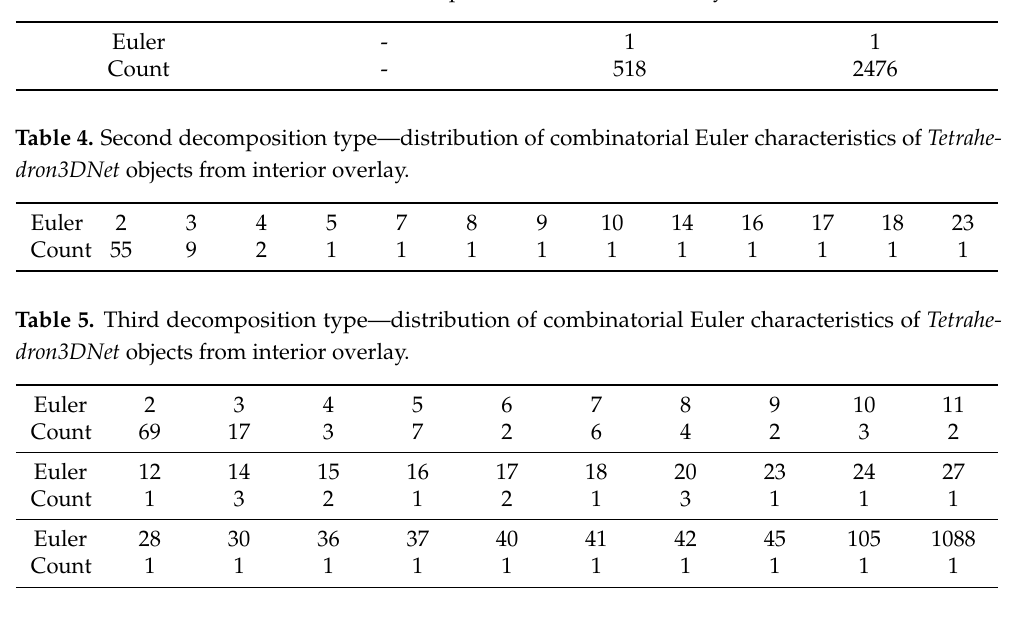
Table 3. First, second and third decomposition types (from left to right)—distributions of combinato- rial Euler characteristics of tetrahedron complexes from interior overlay.